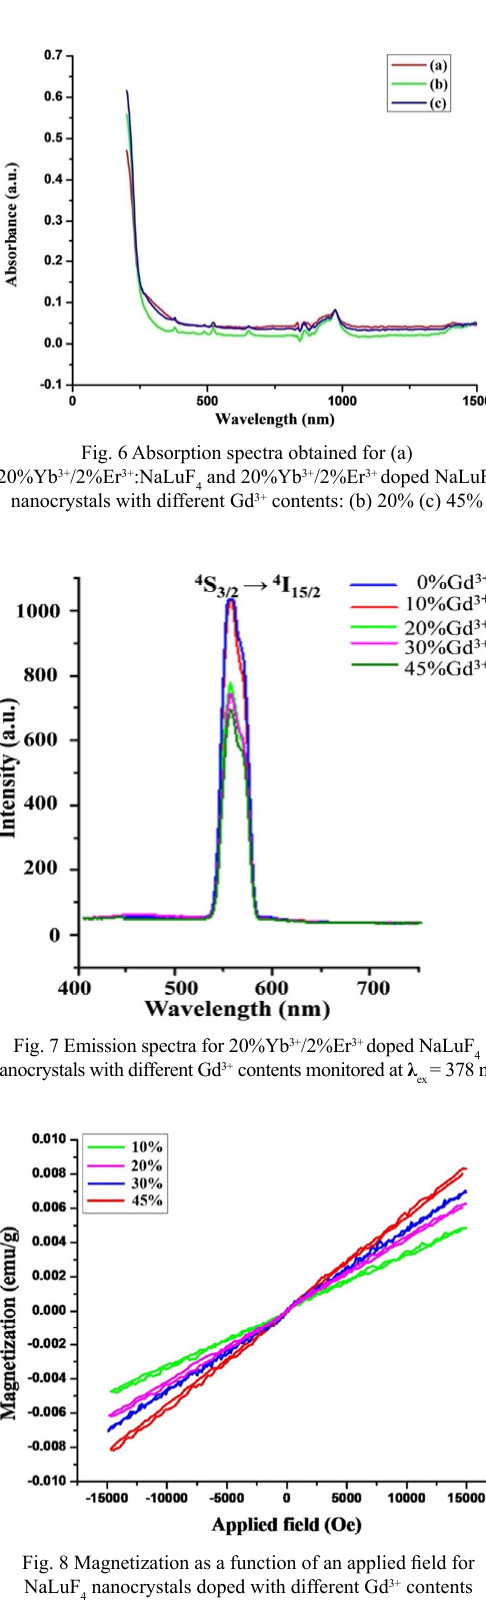
Fig. 8 Magnetization as a function of an applied field for NaLuF 4 nanocrystals doped with different Gd 3+ contents